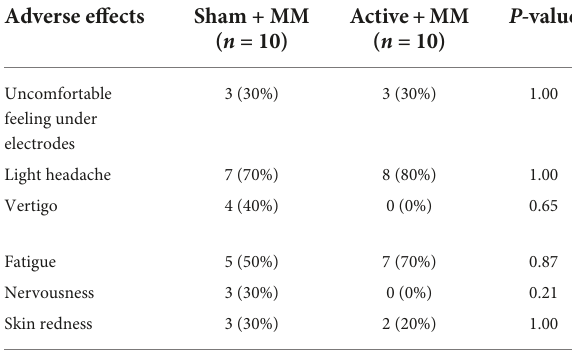
TABLE 3 Adverse effects after concurrent stimulation and